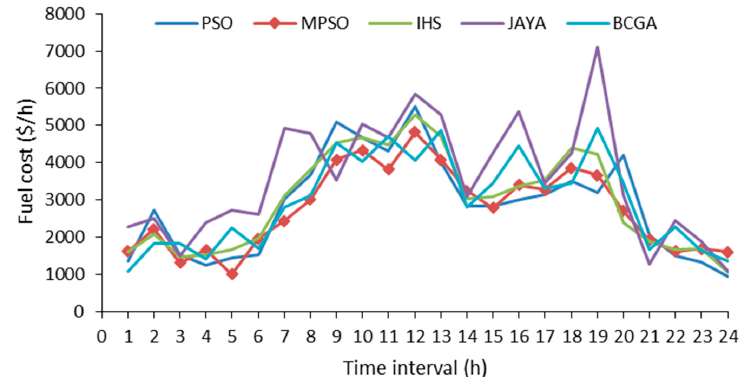
Figure 5. Fuel cost curve obtained from the MPSO, PSO, BCGA, IHS, and JAYA algorithms over the scheduling time.